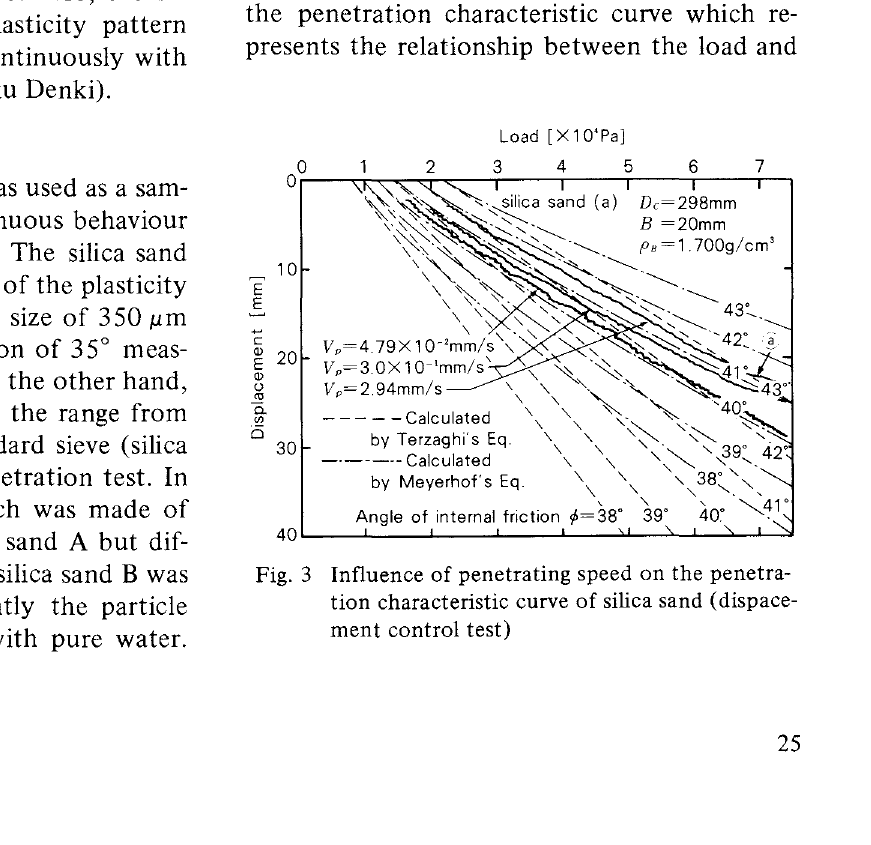
Fig. 3 Influence of penetrating speed on the penetra tion characteristic curve of silica sand ( dispace ment control